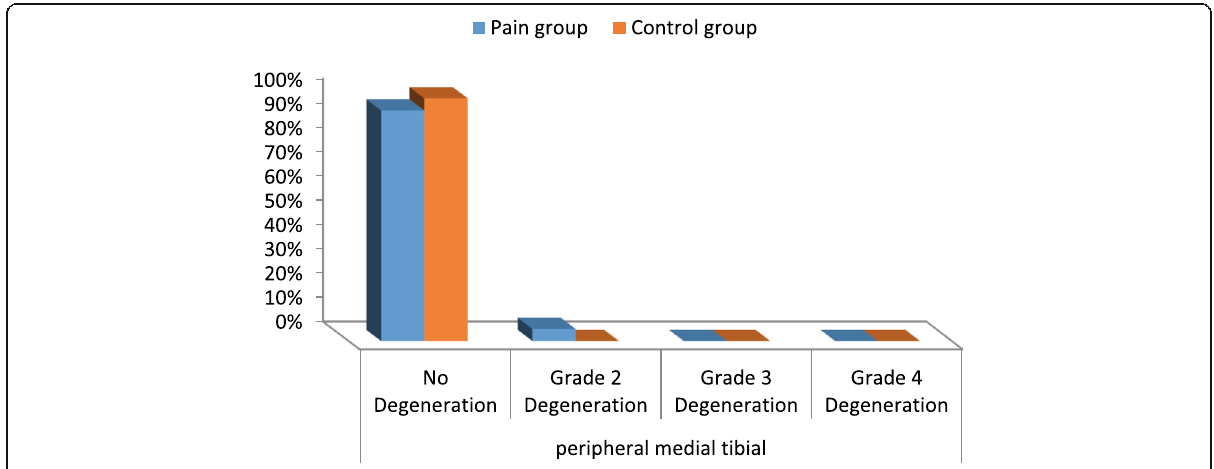
Fig. 9 Distribution of peripheral medial tibial degeneration according to ICRS degeneration